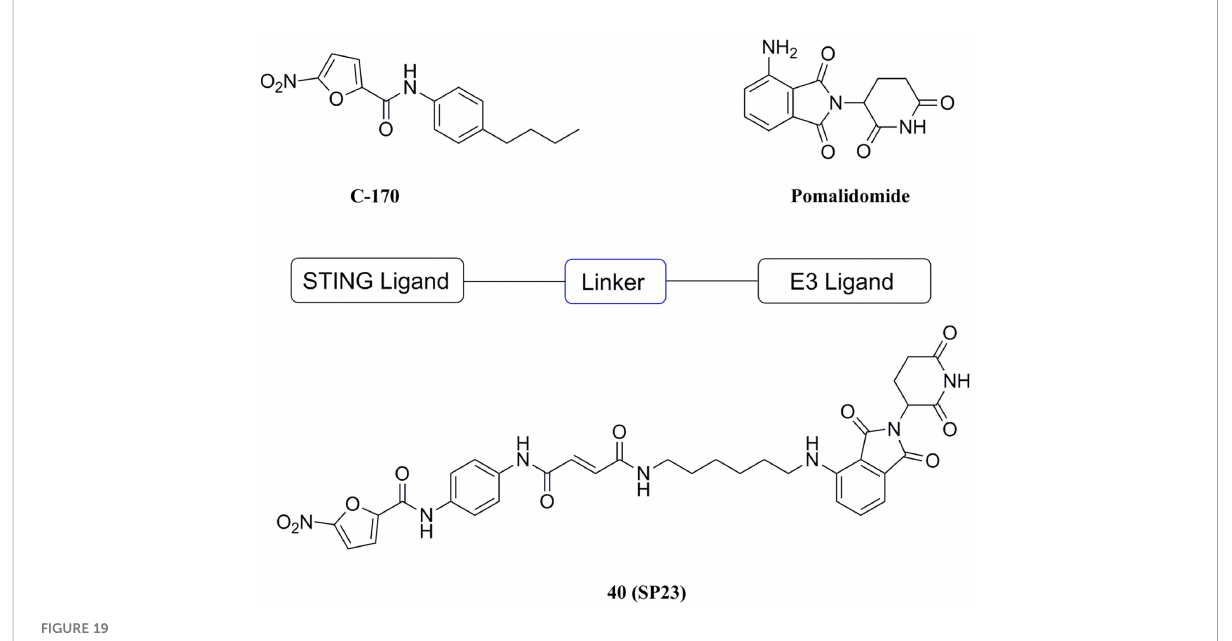
FIGURE 19 PROTAC molecule target